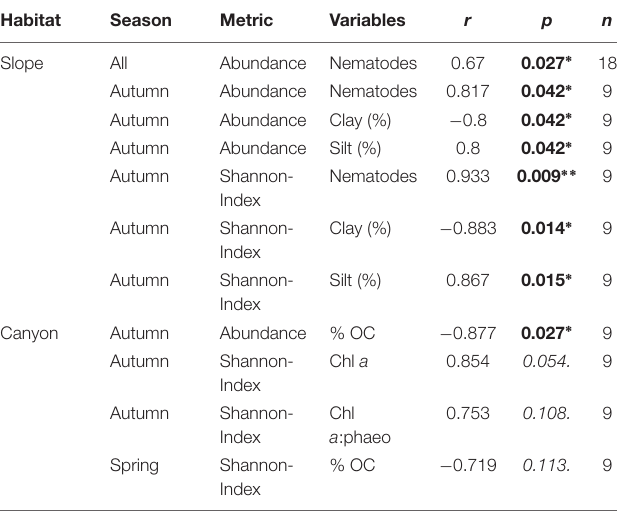
TABLE 3 | Spearman correlations between independent variables (environmental factors and nematode abundance) with microbial metrics (abundance and Shannon index) for both